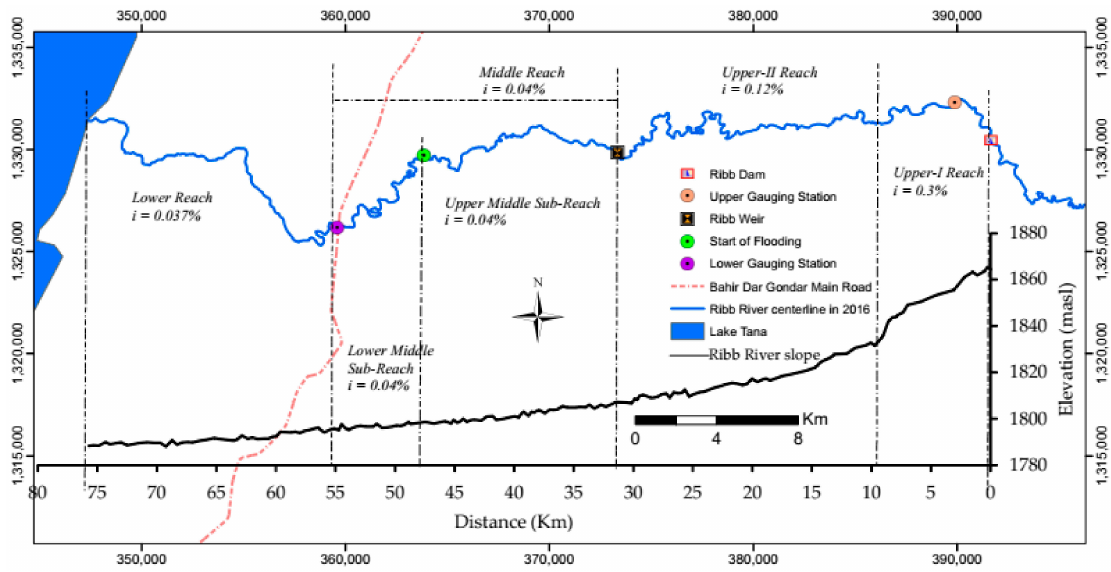
Figure 3. Ribb River study reach, sub-reaches and riverbed profile from the dam site to Lake Tana. The river alignment is derived from Google Earth images of 2016. The slope is obtained from 30 m resolution Digital Elevation Models (DEM) of Advanced Spaceborne Thermal Emission and Reflection Radiometer (ASTER) satellite images of